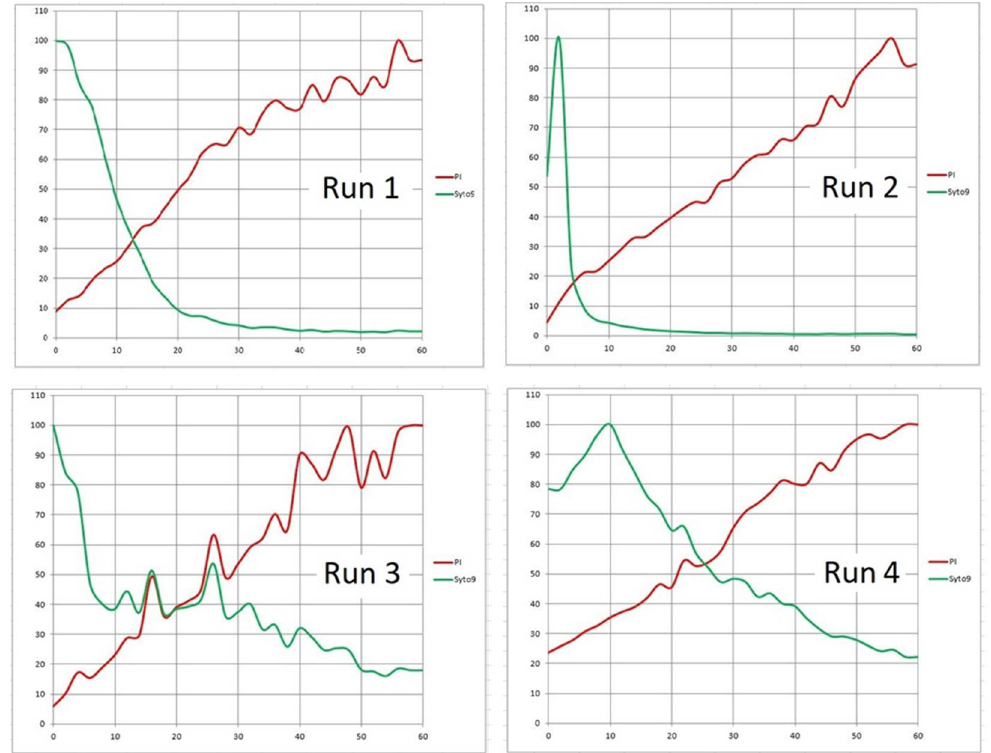
Figure 10. Time-lapse records of PI (red) and Syto 9 (green) fluorescence signal from a mixed biofilm of S. epidermidis and E. coli exposed to Product “A” in four separate assays. Horizontal axis: time in minutes. Vertical axis: % of maximum frame luminance.